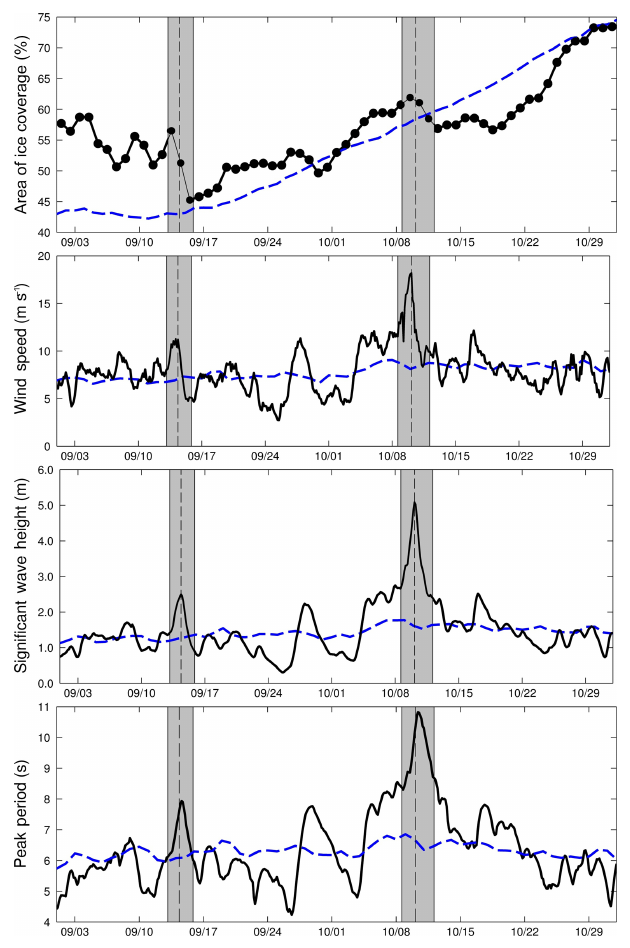
Figure 12. Area-averaged ice coverage, wind speed, significant wave height, and peak period in the Beaufort–Chukchi seas for September–October 2006 (solid line). The dashed line is the daily average from 1992 to